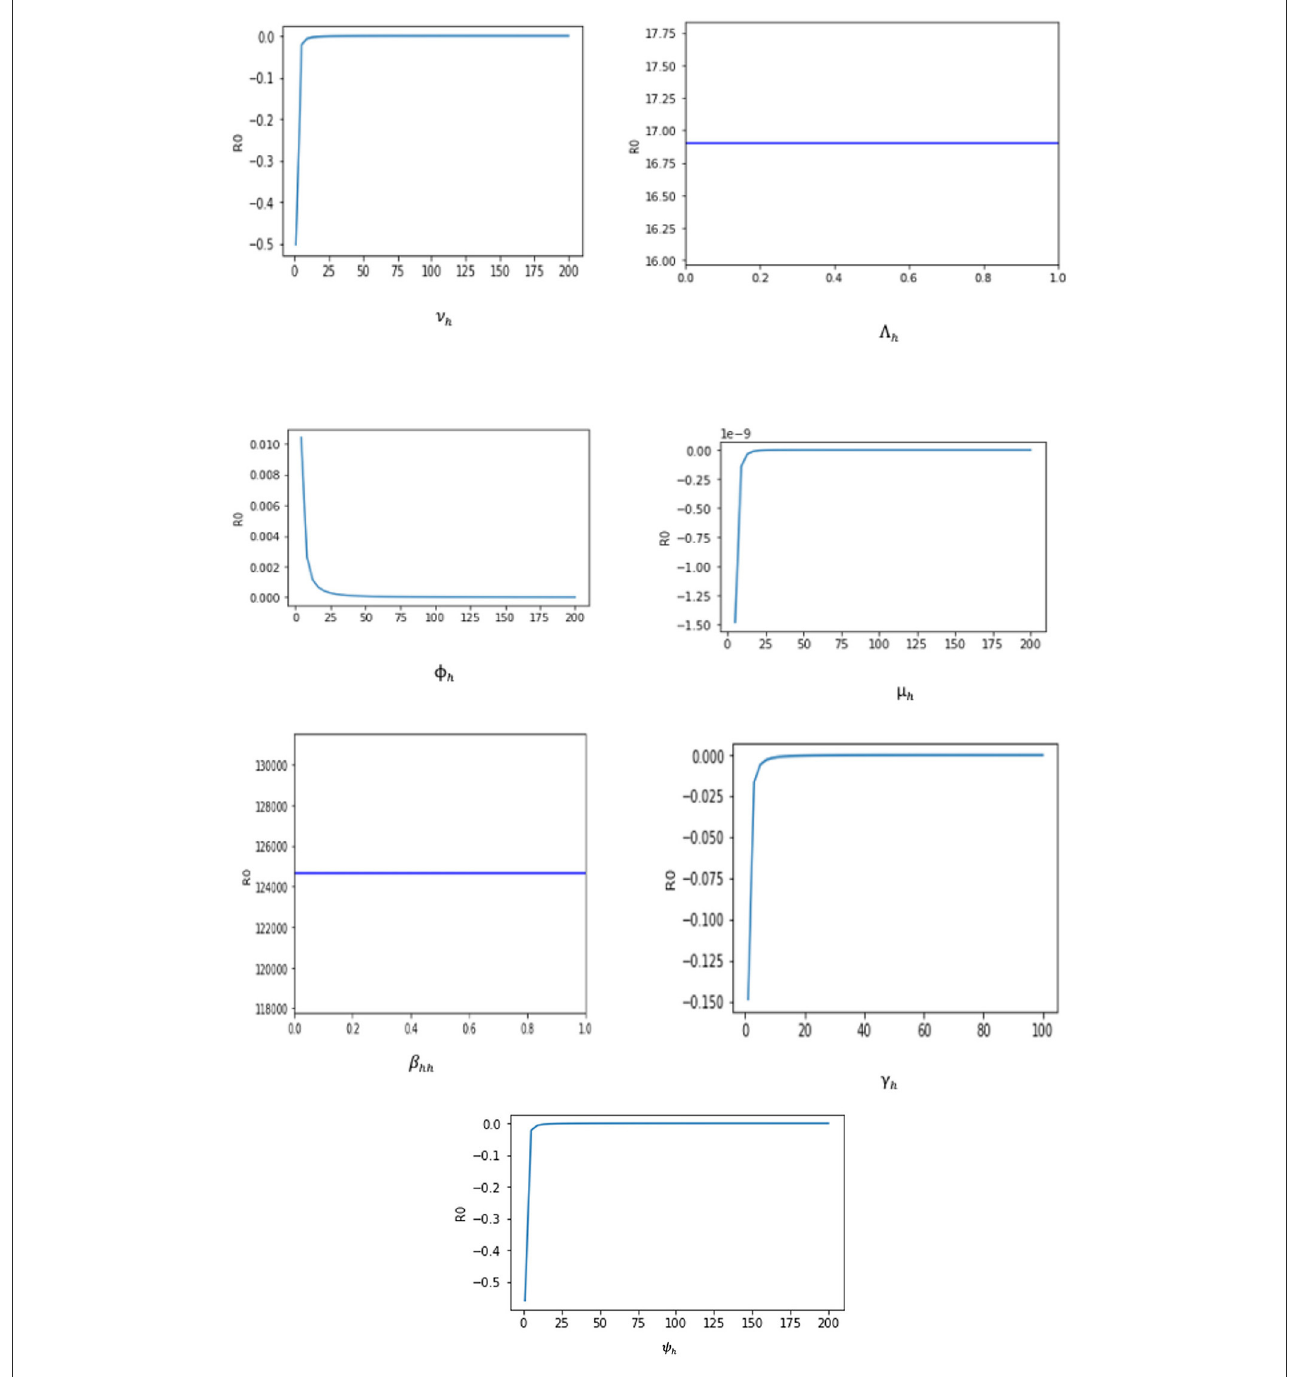
FIGURE3 The sensitivity analysis of R 0 with respect to the parameter p of the system